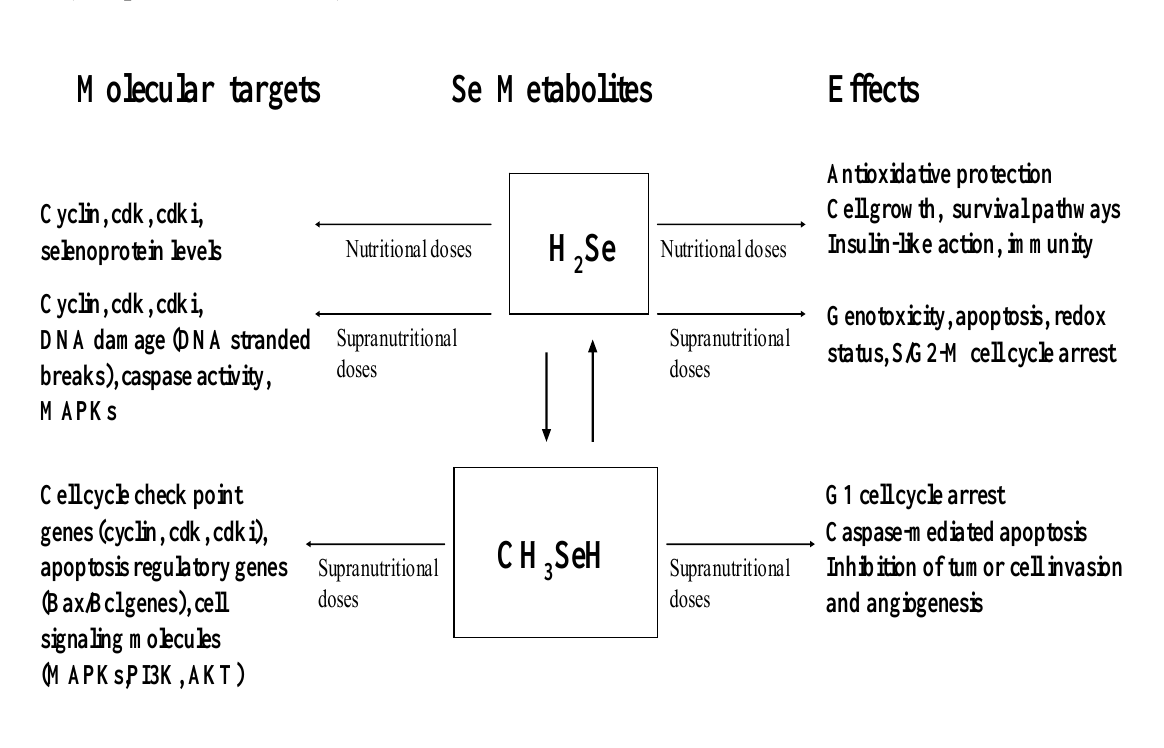
Figure 3. molecular targets and cellular effects of hydrogen selenide and methylselenol (Adapted from